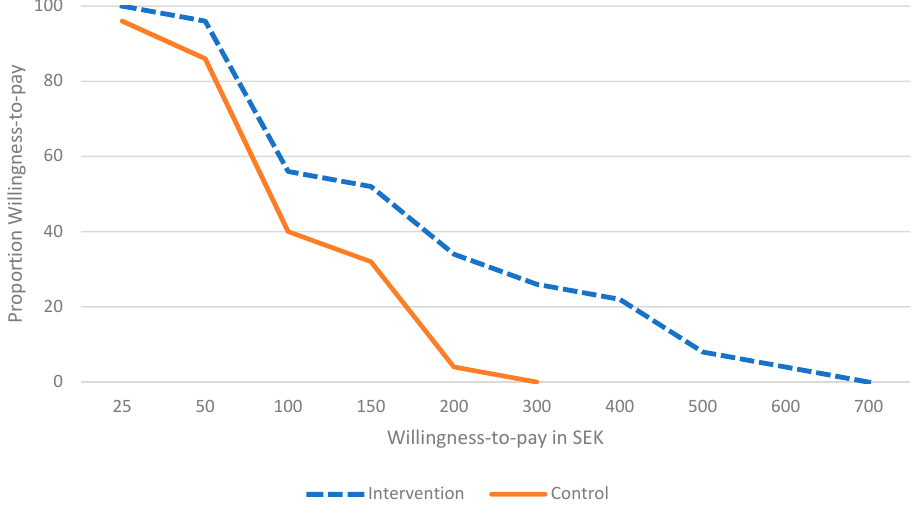
Figure 2. Willingness-to-pay demand curve.